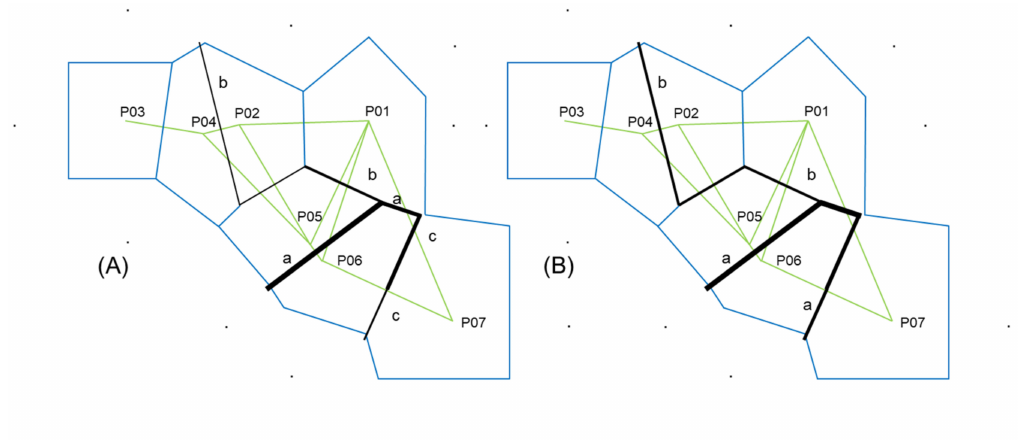
Figure 3. The boundaries obtained with Monmoniers’s maximum difference algorithm of Euclidean distances among populations revealed by program BARRIER. ( A ) The first three boundaries (a–c) for morphometric variation; and ( B ) the first two boundaries (a and b) for chemical variation. The thickness of barriers is related to their importance. Acronyms of